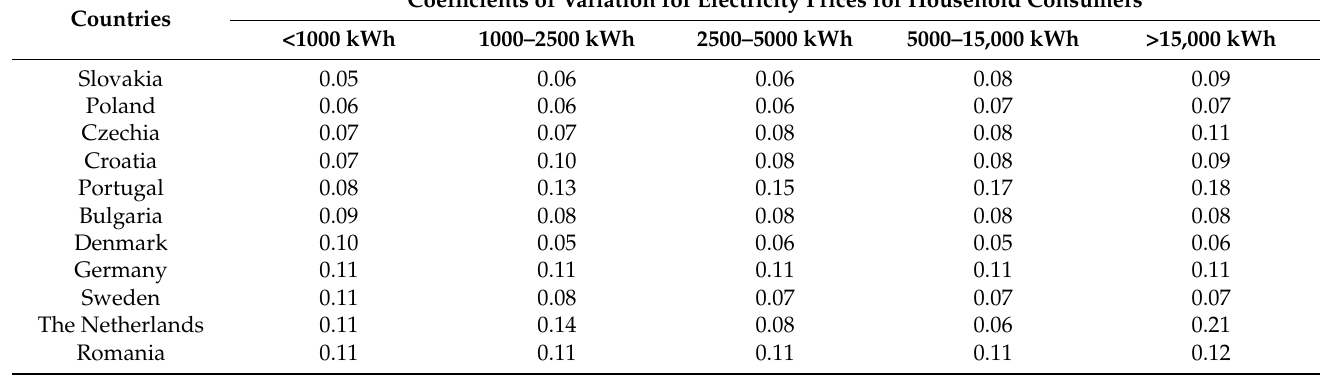
Table 2. Coefficients of variation for electricity prices for private customers by volume of consumption in EU states in 2008–2019.